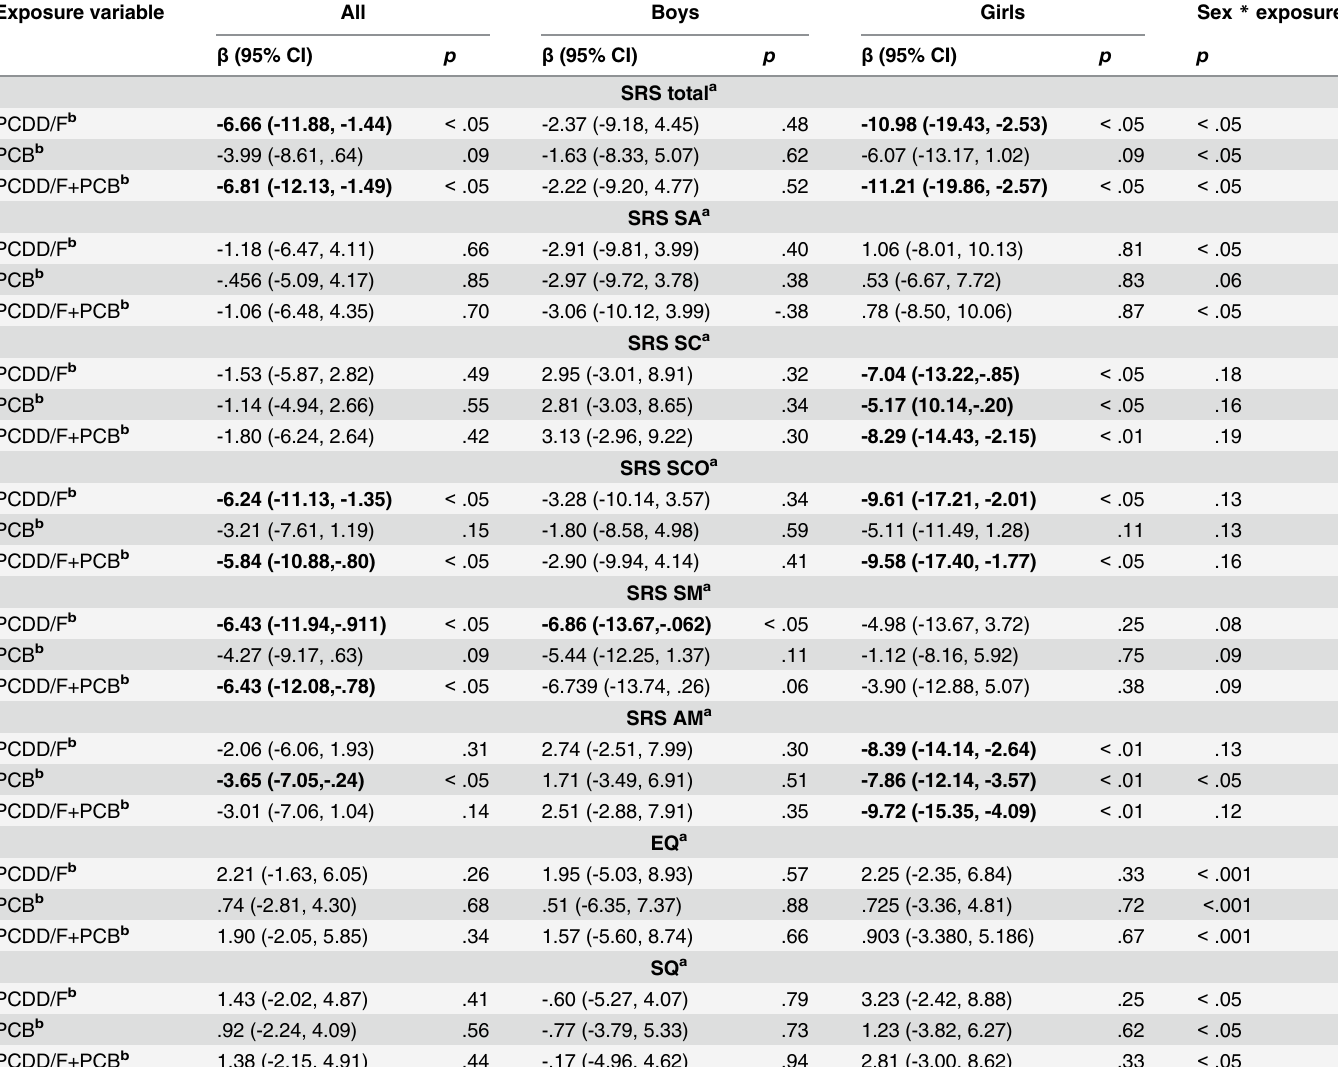
Table 4. Results of the hierarchical regression analyses of associations between concentrations of WHO 2005 -TEq Ʃ PCDD/Fs, Ʃ PCBs and Σ PCDD/ Fs+PCBs in maternal blood [pg/g lipid base], and SRS, EQ and SQ scores. Exposure variable All Boys